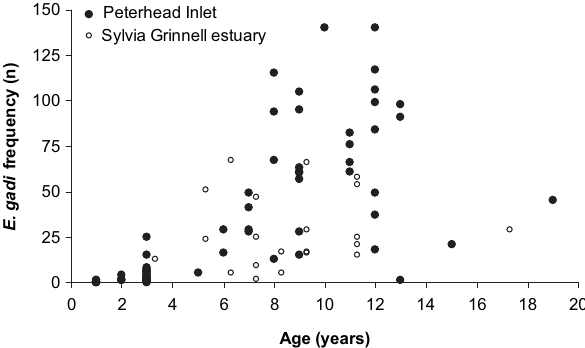
Fig. 4. – Relationship between frequency of Echinorhynchus gadi and age of shorthorn sculpin from Peterhead Inlet and the Sylvia Grinnell River estuary, S TABLE ISOTOPES Stable isotope data was determined for four samples from the Sylvia Grinnell estuary and 42 samples from Peterhead Inlet. δ 15 N ranged from 12.70 to 17.21 ‰ while δ 13 C ranged from - 19.71 to - 16.21 ‰ (Fig. 5). A plot of δ 15 N values against age classes of shorthorn sculpin showed an increase from age 2 to 15 years. A